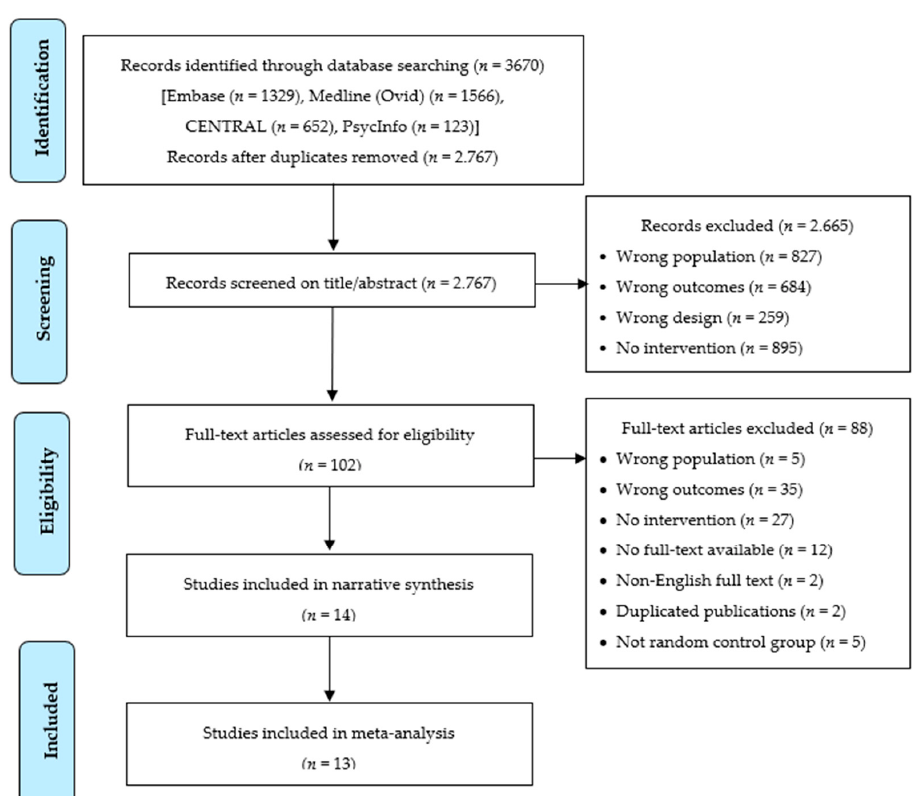
Figure 1. PRISMA flow diagram for study selection.